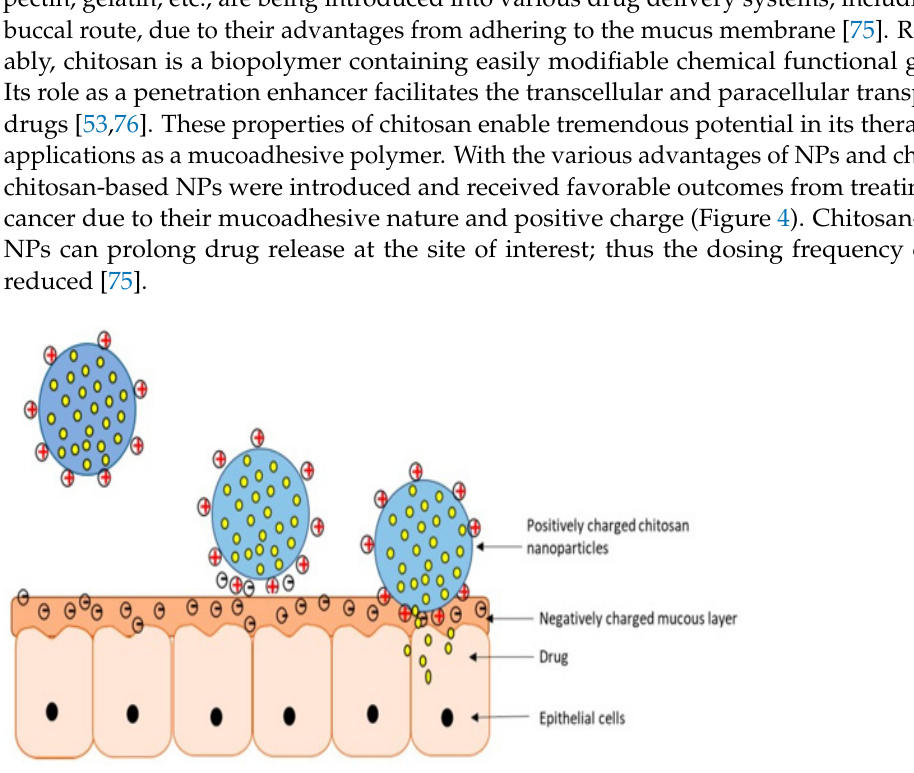
Figure 4. Mucoadhesive properties of chitosan-coated NPs allow prolonged drug delivery at the site of interest [75].